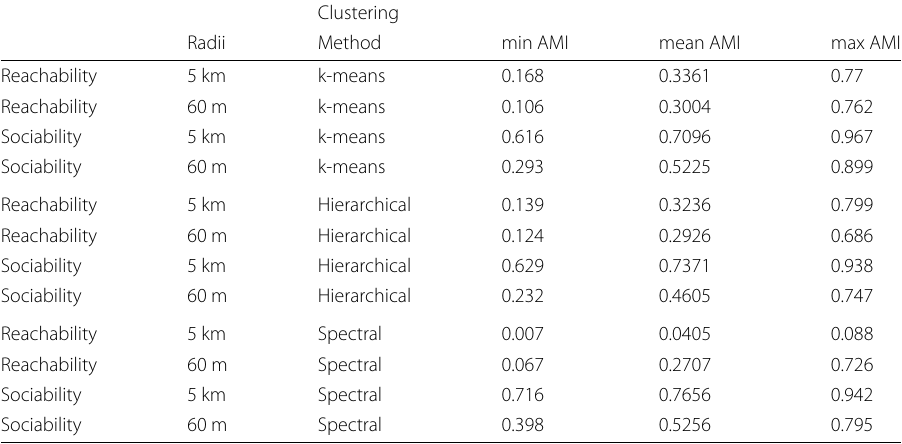
Table 6 Summary of mutual information (AMI) results for sociability and reachability aggregated across travel patterns (modes)